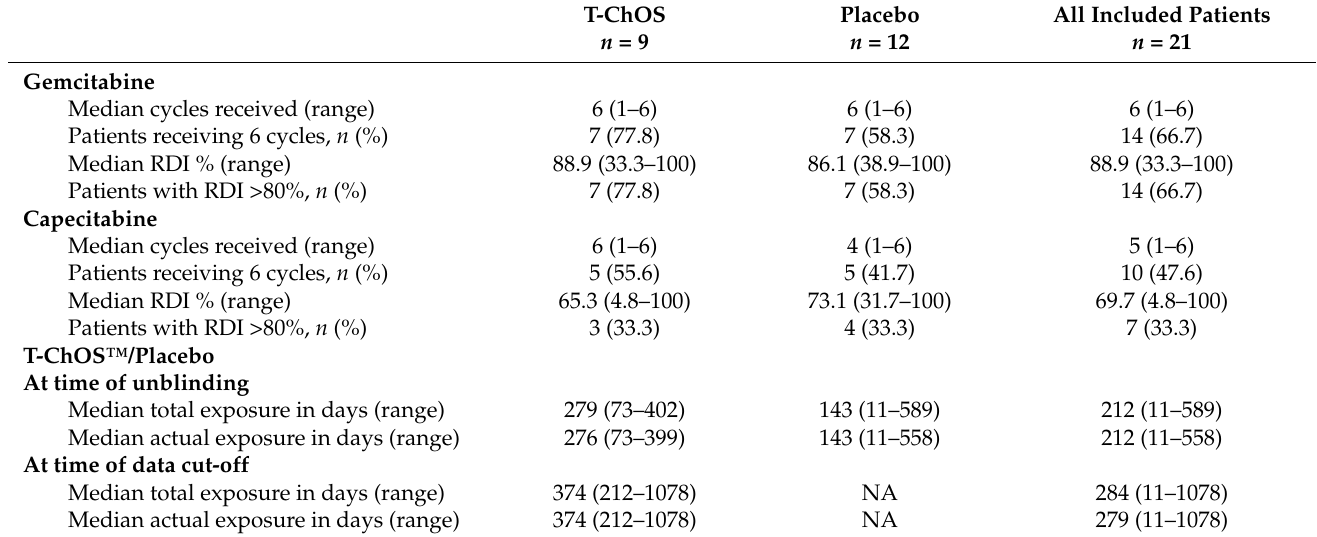
Table 2. Treatment